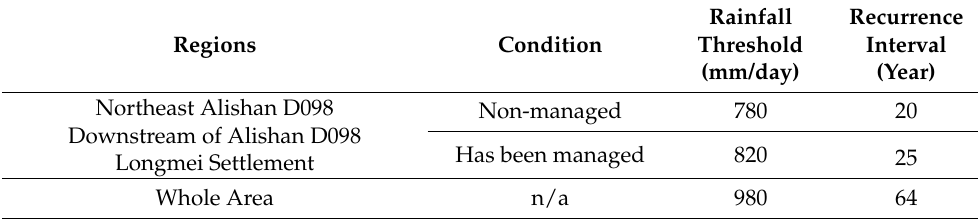
Recurrence Rainfall Interval Threshold (Year) (mm/day)